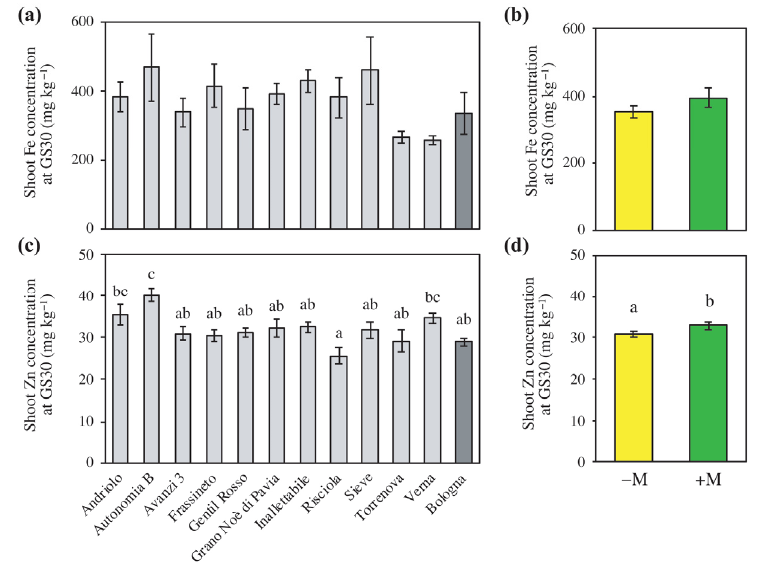
Figure 3. Effects of wheat genotype and AMF inoculation on shoot Fe concentration ( a,b ), and shoot Zn concentration at GS30 ( c,d ). AMF inoculation and mock control are indicated as +M and − M, respectively.